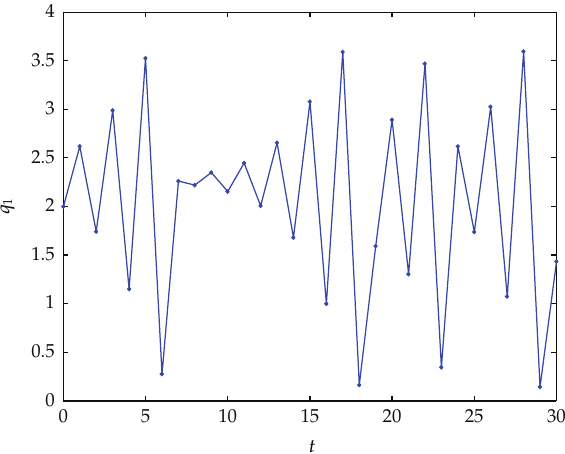
Figure 4: Chaotic values of q 1 versus time for β (cid:7) 0 . 2 ,α (cid:7) 23 .